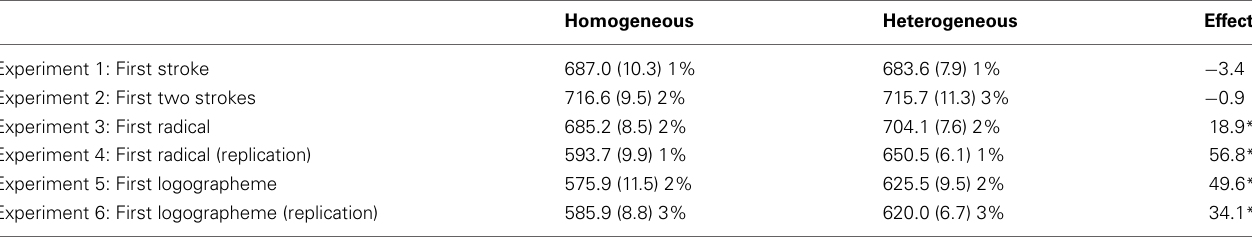
The percentages are mean error rates. * The effect is significant at p < 0 . 0001